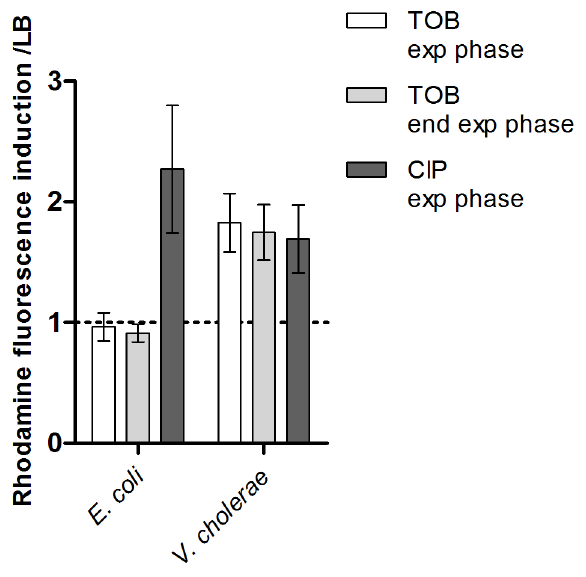
Figure 1. Sub-MIC tobramycin treatment induces ROS forma- tion in V.cholerae and not in E.coli . Histogram bars show the ratio of rhodamine fluorescence in the presence of the specified antibiotic over fluorescence in LB and thus reflect the induction of ROS formation. Tobramycin (TOB) and ciprofloxacin (CIP) concentrations were respec- tively 0.01 m g/ml and 0.005 m g/ml for V. cholerae , and 0.1 m g/ml and 0.05 m g/ml for E. coli . Exp phase stands for exponential phase i.e. an OD600 nm of 0.5. End exp phase stands for end of exponential phase i.e. an OD600 nm of 0.8.